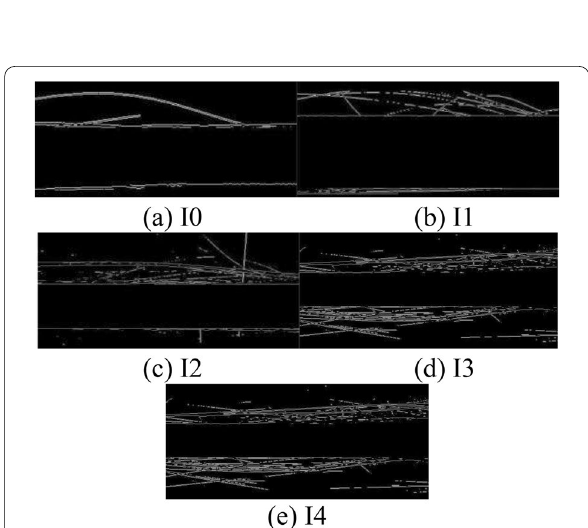
Figure 17 Z-yarn surface hairiness at different implantation times